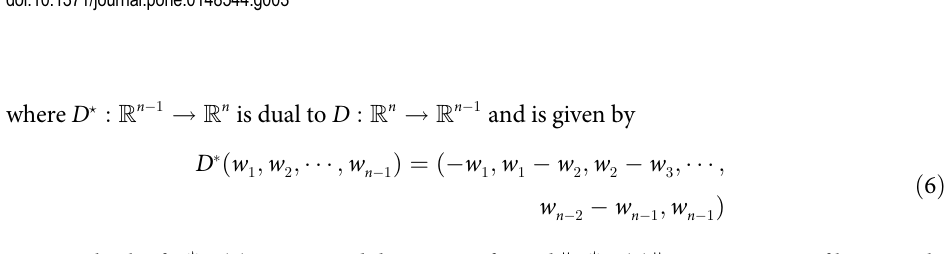
Fig 3. Taut String. X axis is the time in seconds (example shown is 60 seconds), Y axis is epsilon width from the origin for piecewise linear reconstruction. (a)The black and red waveforms are the taut-string margins, z − ε and z + ε , and the dotted blue lines is the taut-string estimation; (b) Shows the reconstructed signal based on the taut-string estimation.